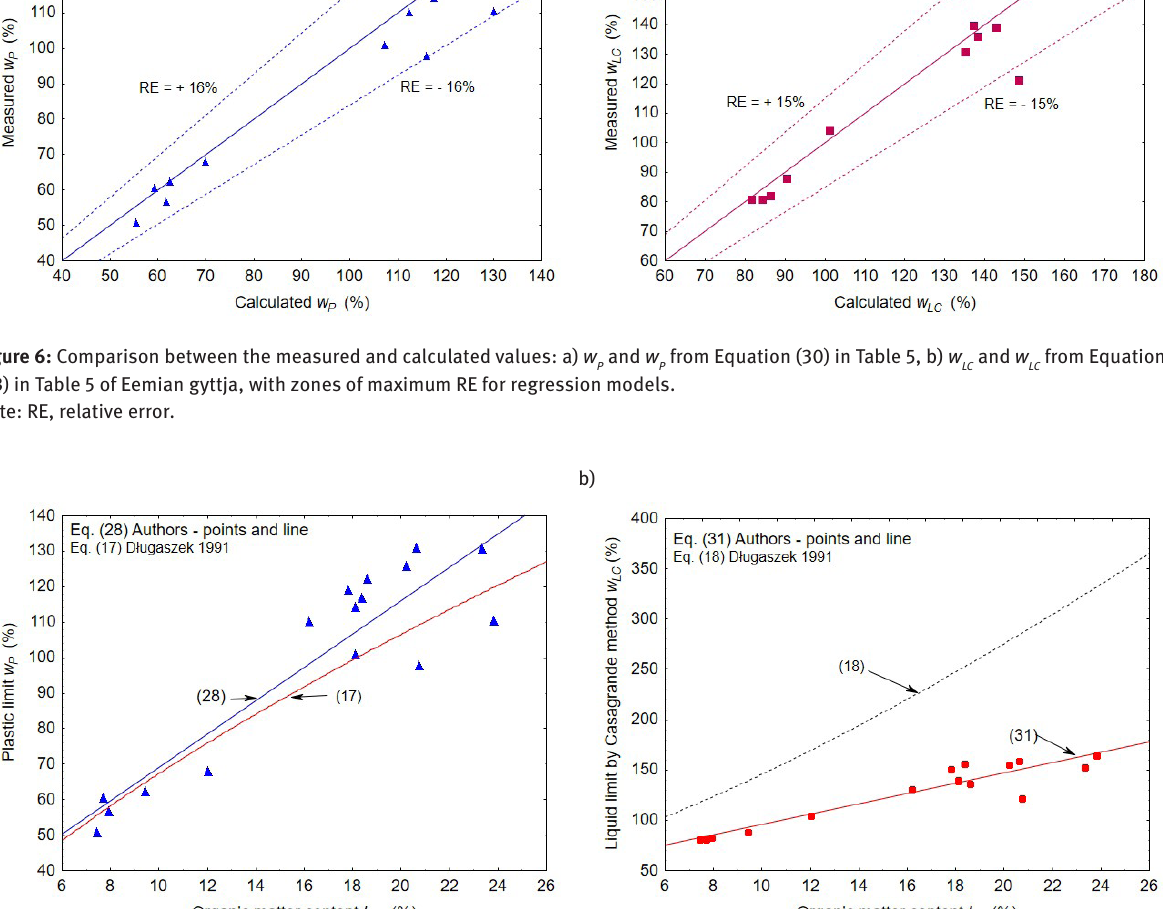
Figure 7: Comparison of relationships obtained by the authors for Eemian gyttja with the relationships for Holocene gyttja obtained by Długaszek: a) w = f( I ), b) w = f( I P om LC om